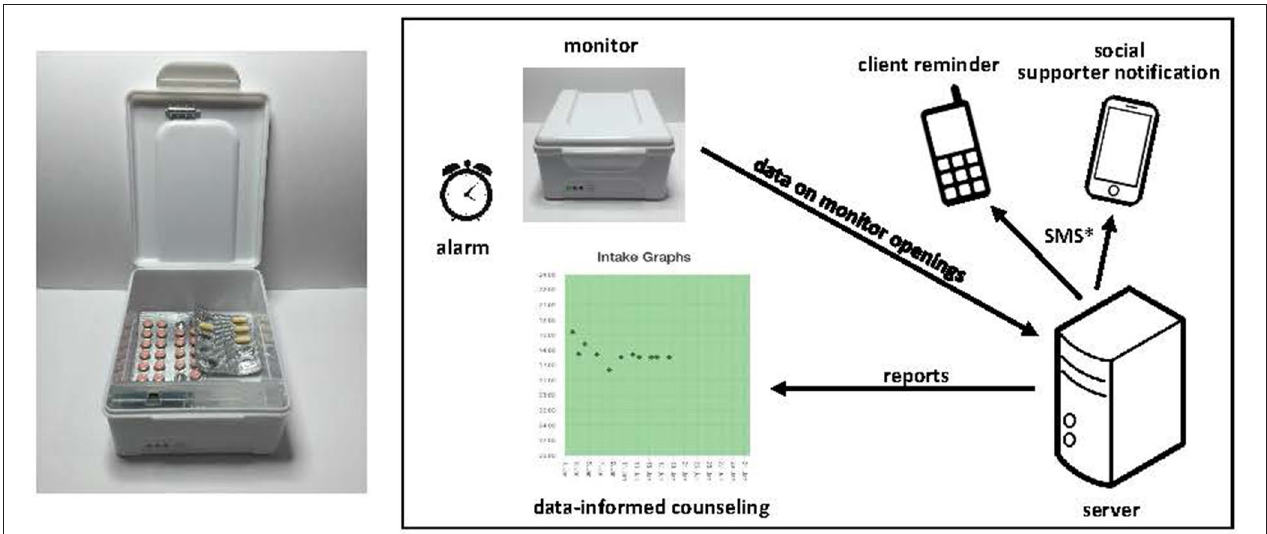
FIGURE 1 | The evriMED monitor and associated interventions. *SMS may be scheduled or triggered by a delayed or missed dose; they may also involve 1- or 2-way